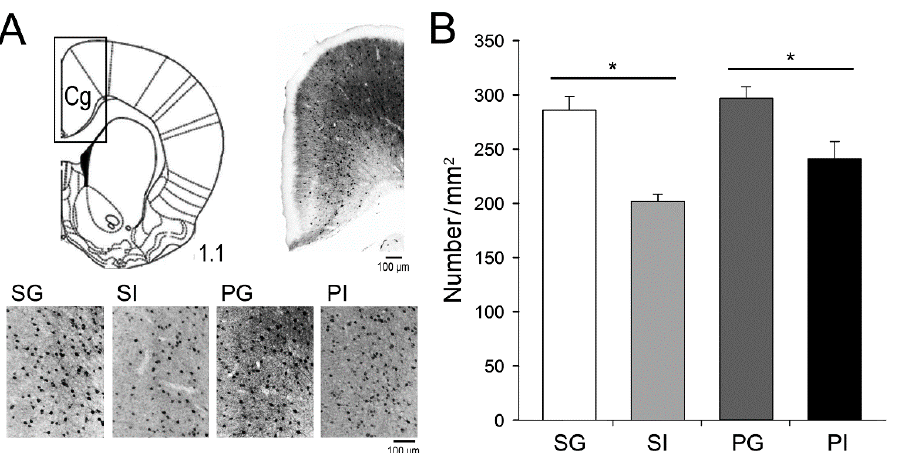
Figure 6. Density of parvalbumin (PV)-positive neurons in the mPFC. ( A ) PV-positive neurons in the mPFC (Cingulate cortex, Cg) were revealed using immunohistochemistry and ( B ) the density was measured. Results are mean ± SEM ( n = 8–12 mice per group). * p < 0.05.